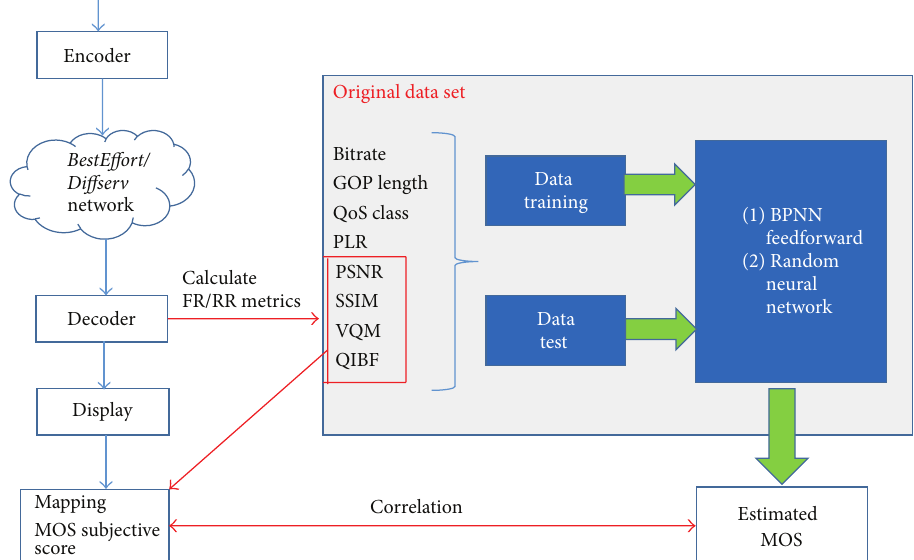
Figure 4: Proposed methodology to estimate the MOS metric using machine learning